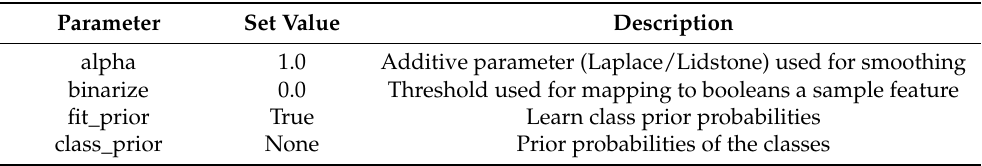
Table 8. Parameters of mechanism set for